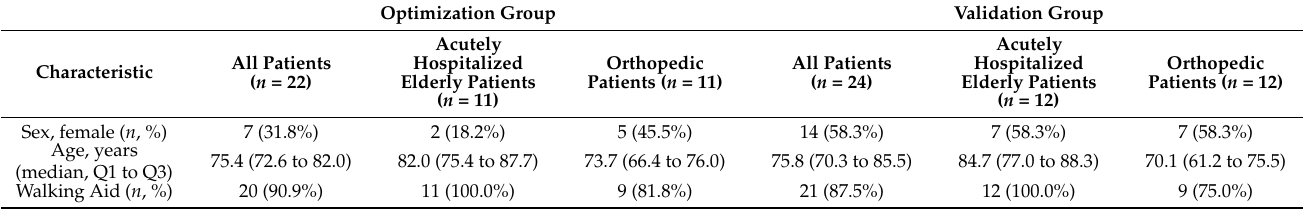
Table 2. Characteristics of study participants in the optimization and validation